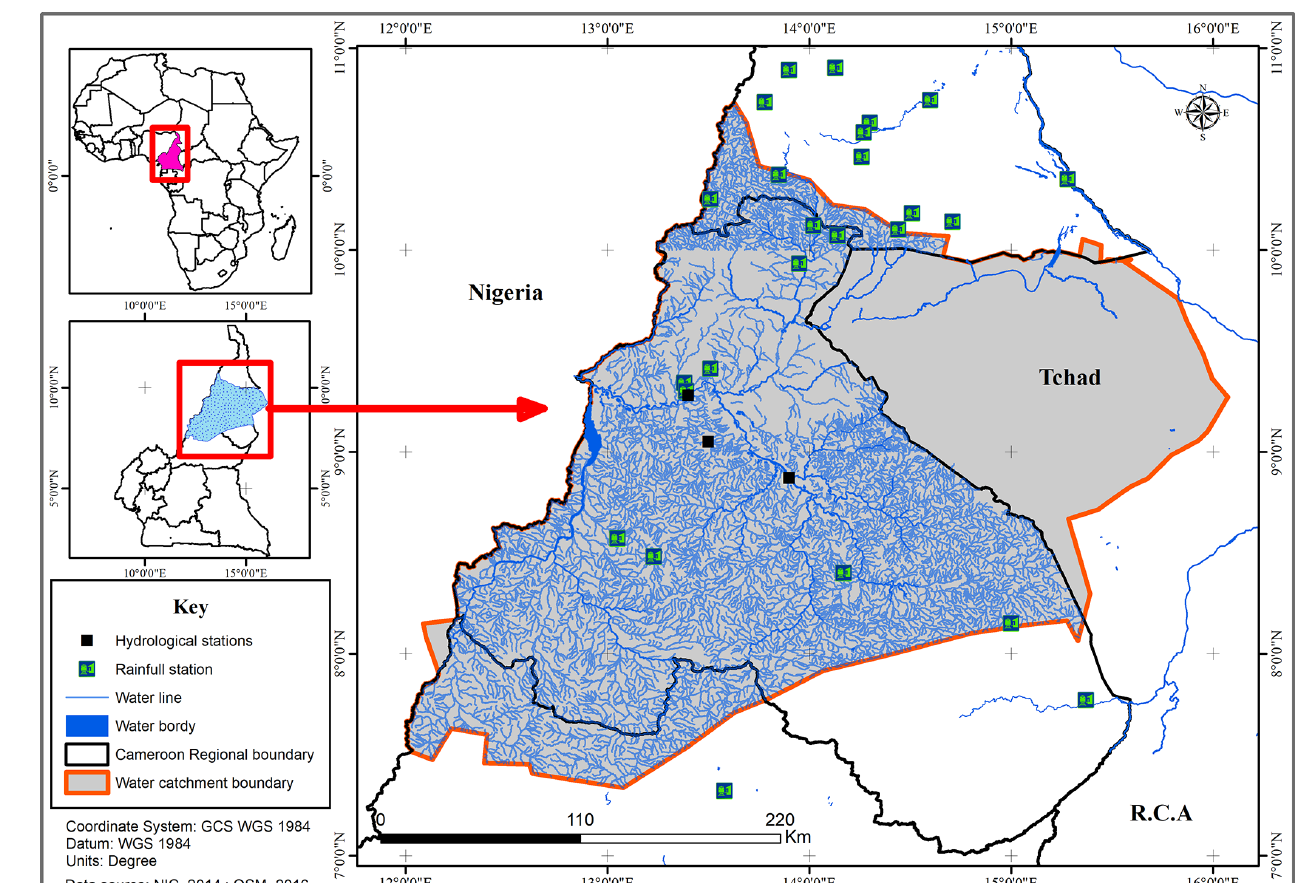
Figure 1. Study catchment: basin drainage area and rainfall and hydrological